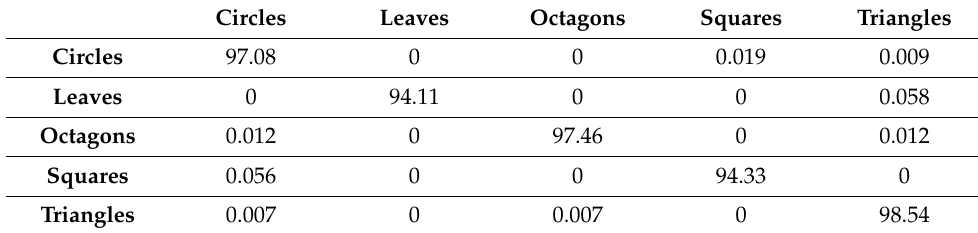
Table 5. The confusion matrix of the accuracy corresponding to the five floor mosaic patterns. Circles Leaves